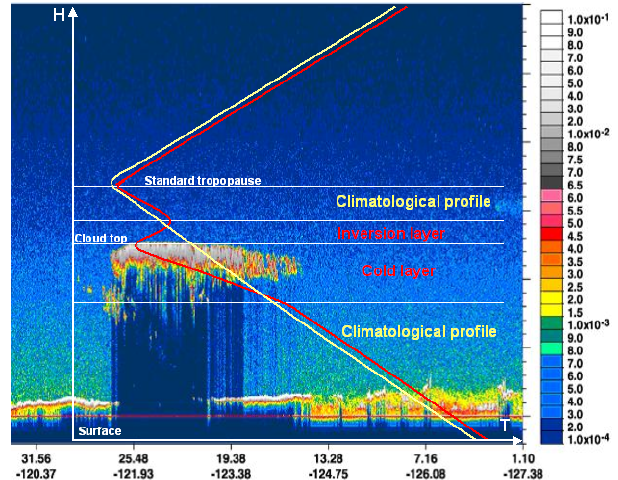
Fig. 9. Vertical profile of the GPS lapse rate ( − d T /d z ) calculated with respect to the altitude of the cloud top derived from the corre- sponding CALIOP measurements for 53 convective systems (blue lines). The red line is the convective systems average, the black line is the averaged climatological lapse rate and the dotted verti- cal green line is the dry adiabatic lapse rate (9.8Kkm − 1 ).